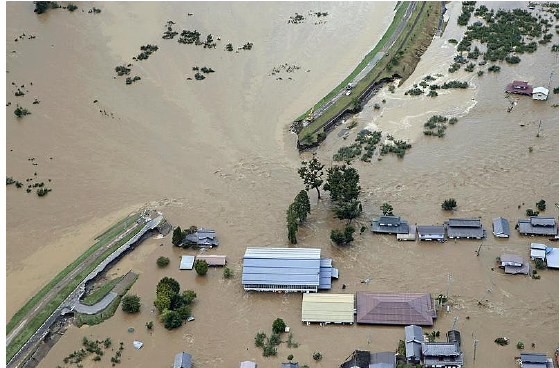
Figure 1. Breach of a dike in Japan in 2019. Image source: The Japan